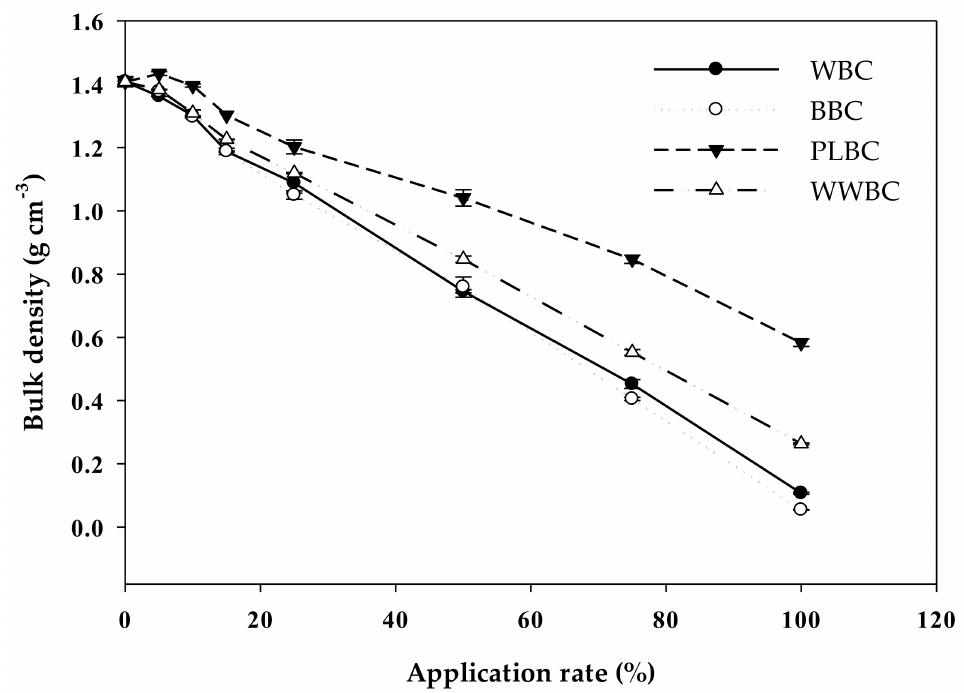
Figure 1. Effects of woodchip biochar (WBC), bagasse biochar (BBC), poultry litter biochar (PLBC) and waterweed biochar (WWBC) on bulk density (BD) by application rate ( v / v